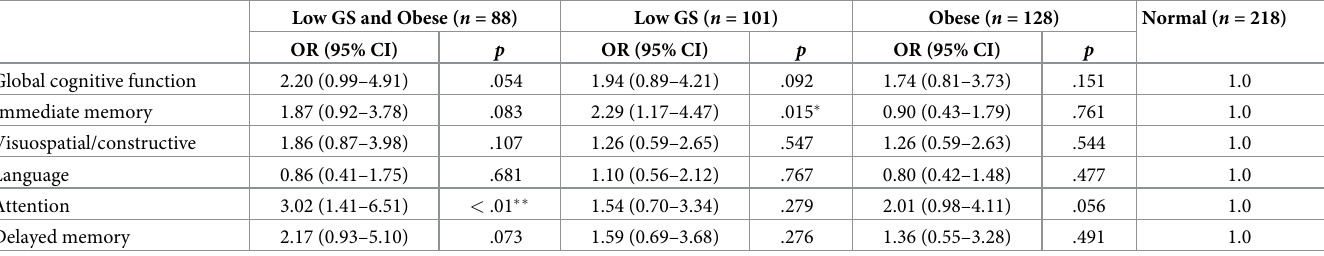
Table 5. Association between gait speed, obesity, and risk of impairment in different domains of cognitive